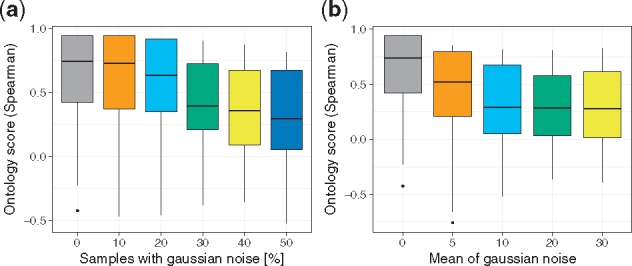
(a) Changes in the distribution of the ontology score depending on artificial Gaussian noise N(μ = 10, σ = 1) added to a subset of GTEx samples across all tissues. The fraction of samples that was contaminated with noise is shown on the x-axis. With increasing contamination, the score is dropping. (b) Depicts how the score is influenced by varying the mean (μ) of Gaussian noise added to the samples. For this experiment, noise is added to 50% of all samples across all tissues, with varying mean. With increasing noise intensity, the score drops and remains constant after μ > 10